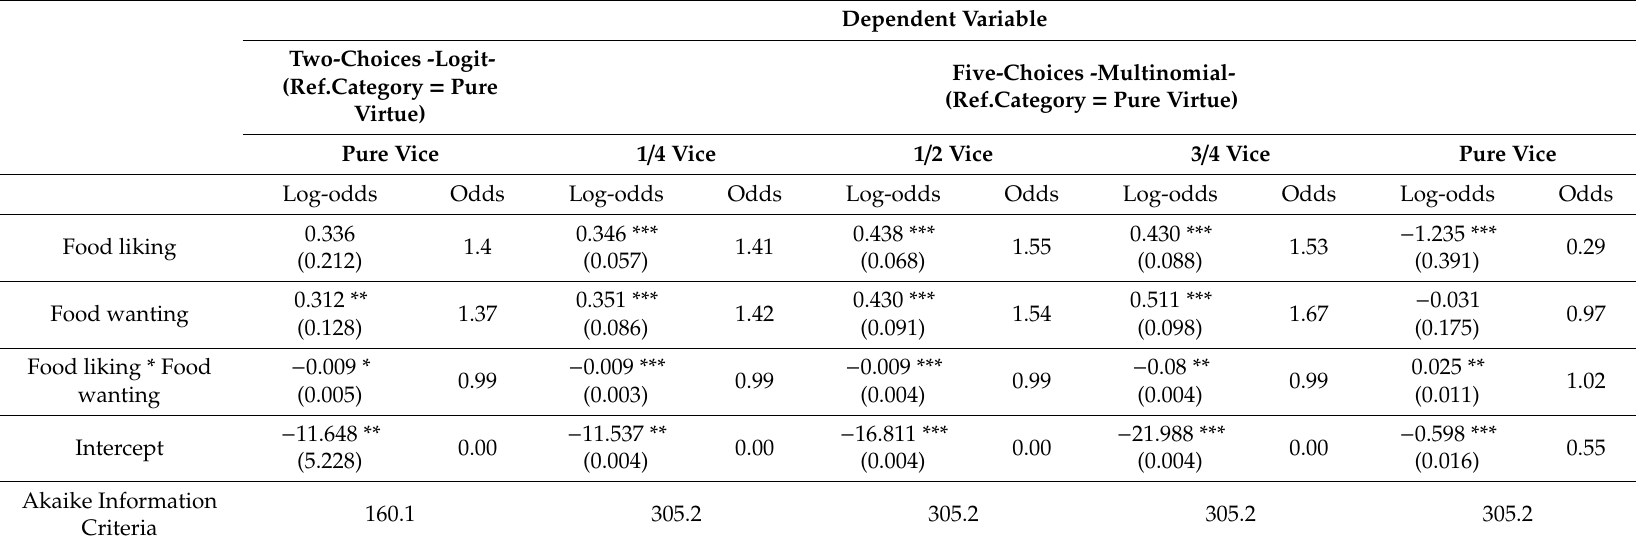
Table 6. Logistic and multinomial regression results. (food choices vs. food liking + food